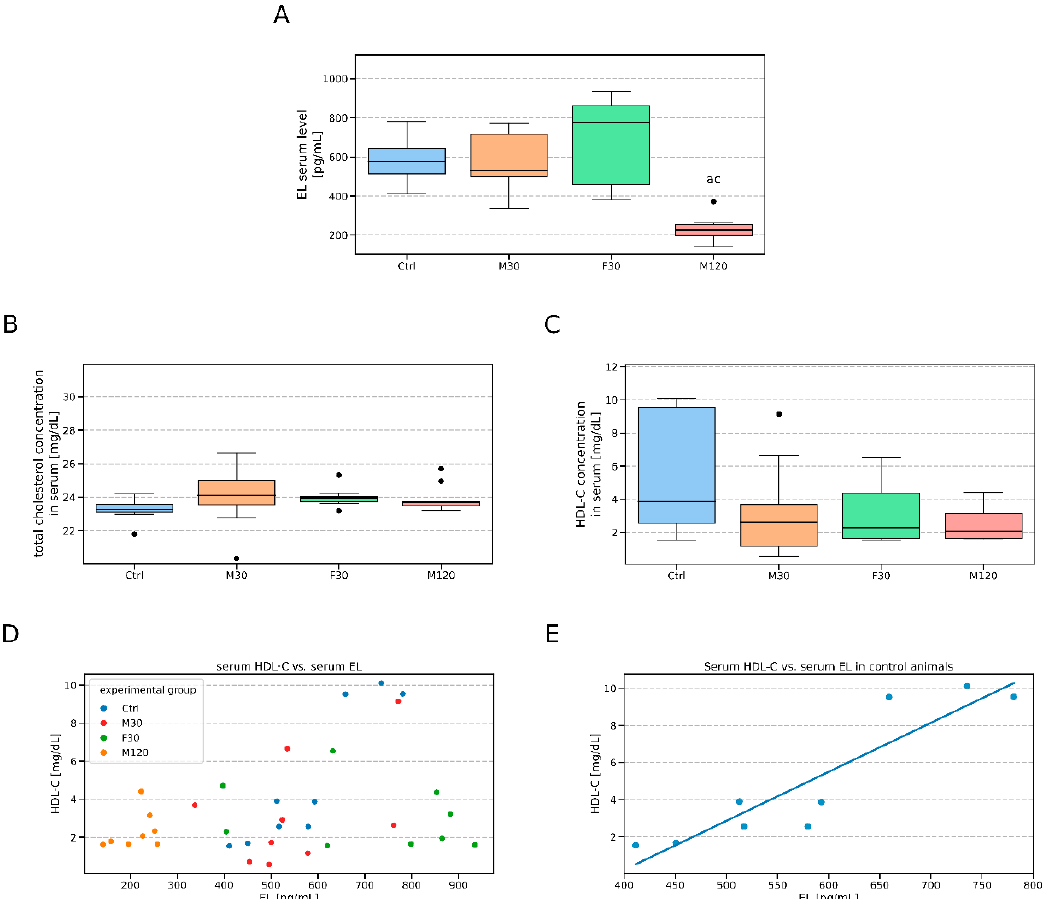
Figure 4. Serum endothelial lipase (EL) concentration and cholesterol profile in Wistar rats at rest and after a treadmill run. Serum endothelial lipase concentration ( A ), total cholesterol ( B ), HDL cholesterol ( C ), correlation between serum HDL cholesterol and EL concentration in all tested groups ( D ), correlation between serum HDL cholesterol and EL concentration in the control group ( E ). The inner horizontal line of a box represents the median. Box boundaries: 25–75 percentile, box whiskers: 1.5 interquartile range or max/min value in the group. Solid black dot—data point laying outside 1.5 * IQR (the interquartile range). The values are expressed in picograms per milliliter of serum. a—difference vs. control (Ctrl), p